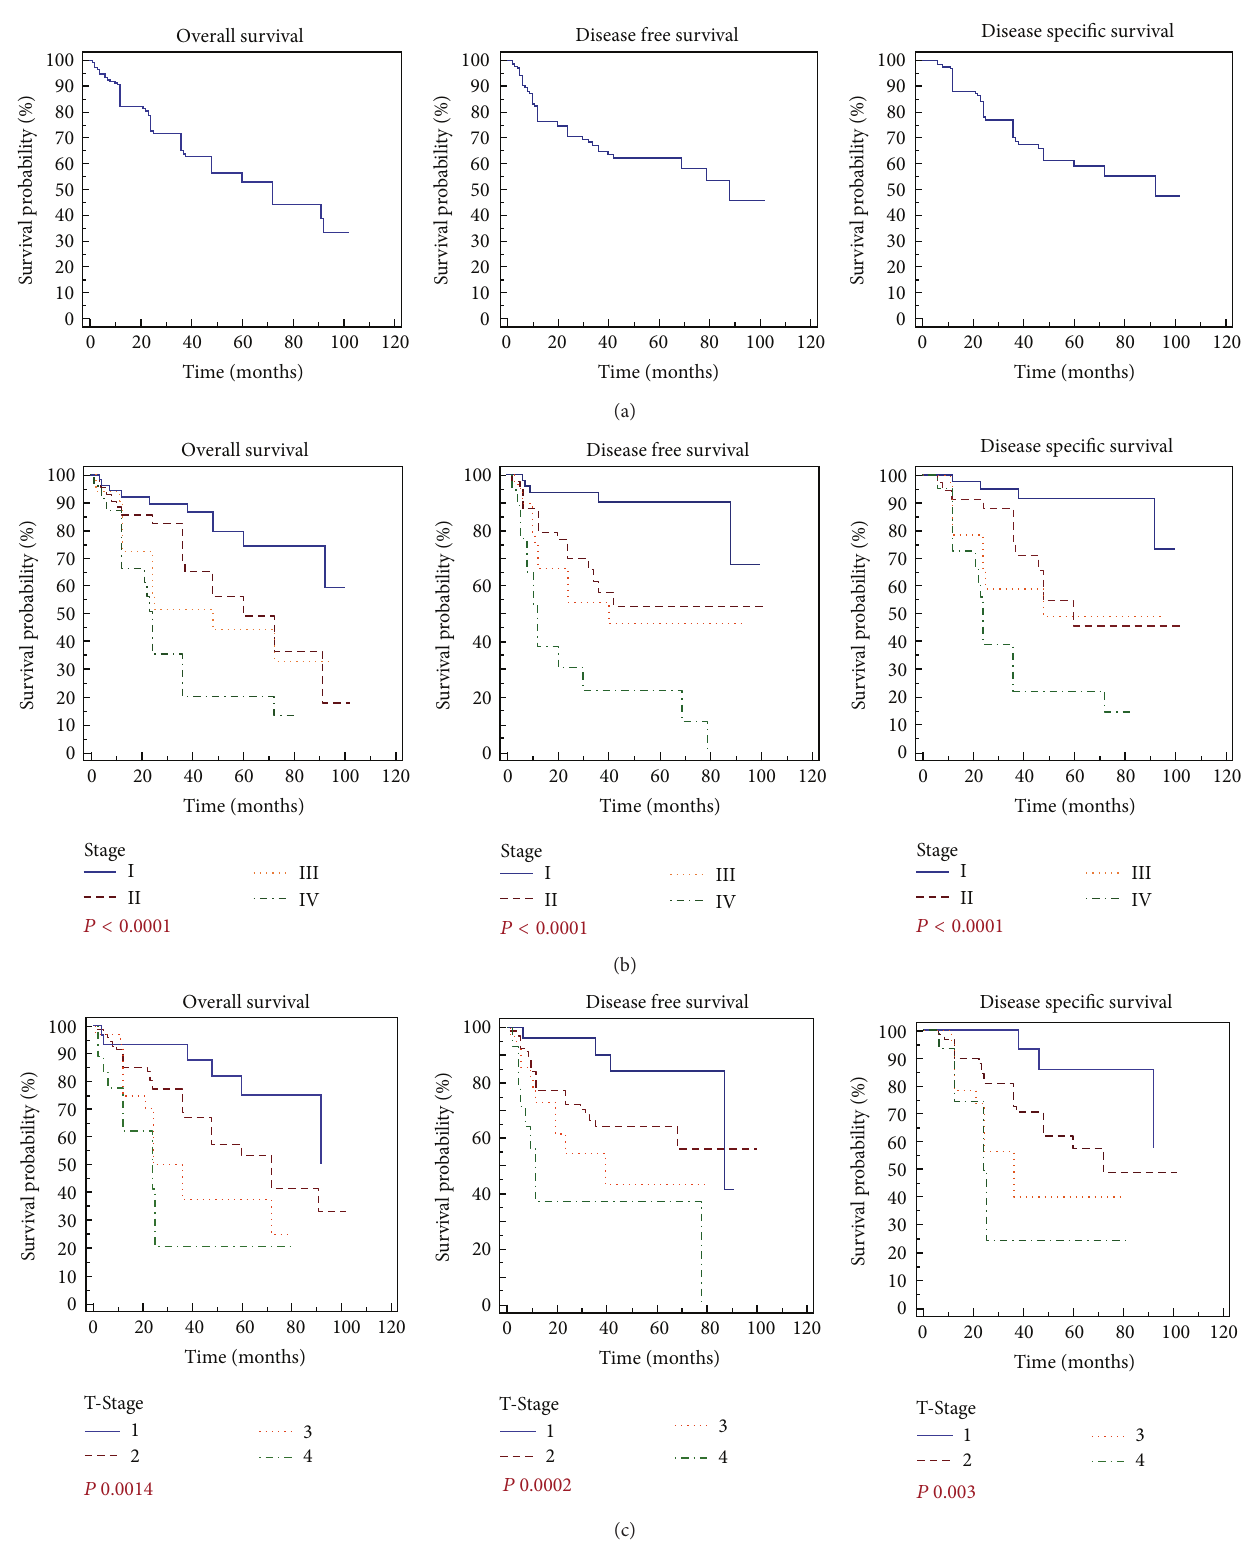
Figure 2: Gastric cancer and survivals. (a) Overall survival, disease free survival, and disease specific survival of R0 gastric resection for adenocarcinoma of the stomach; (b) overall survival, disease free survival, and disease specific survival analysis according to the Stage of the disease; (c) overall survival, disease free survival and disease specific survival according to the depth of tumors infiltration